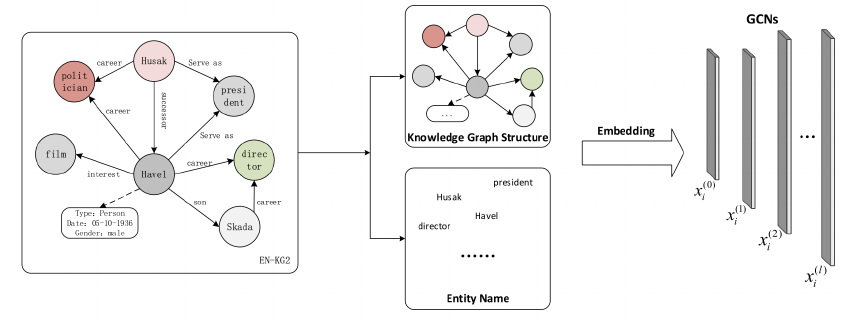
Figure 8. The GCN embedding structure of our